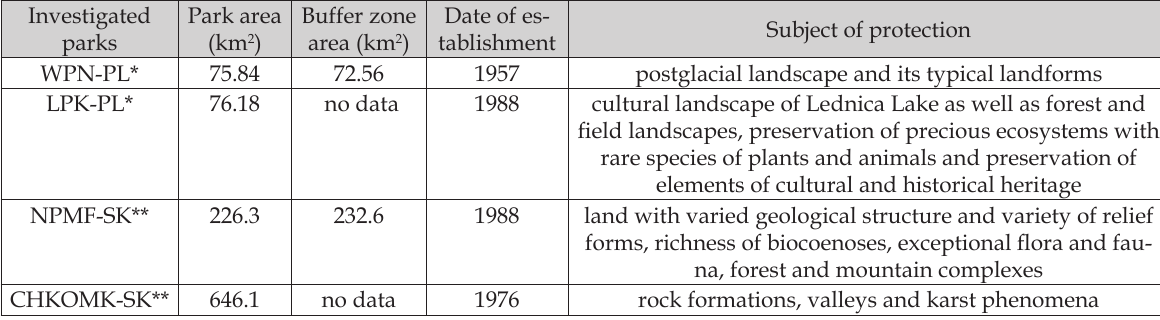
Table 1. Characteristics of the selected parks.